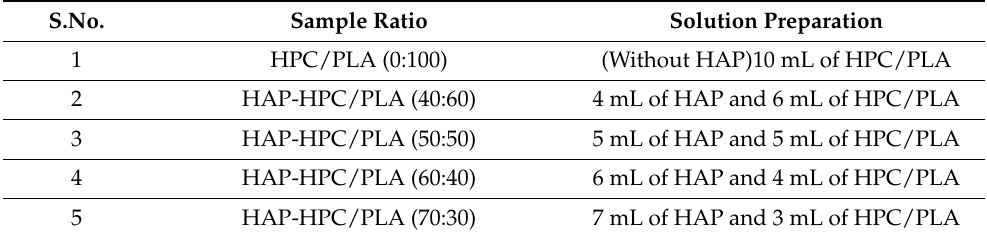
Table 1. The composite mixture and the volume of the